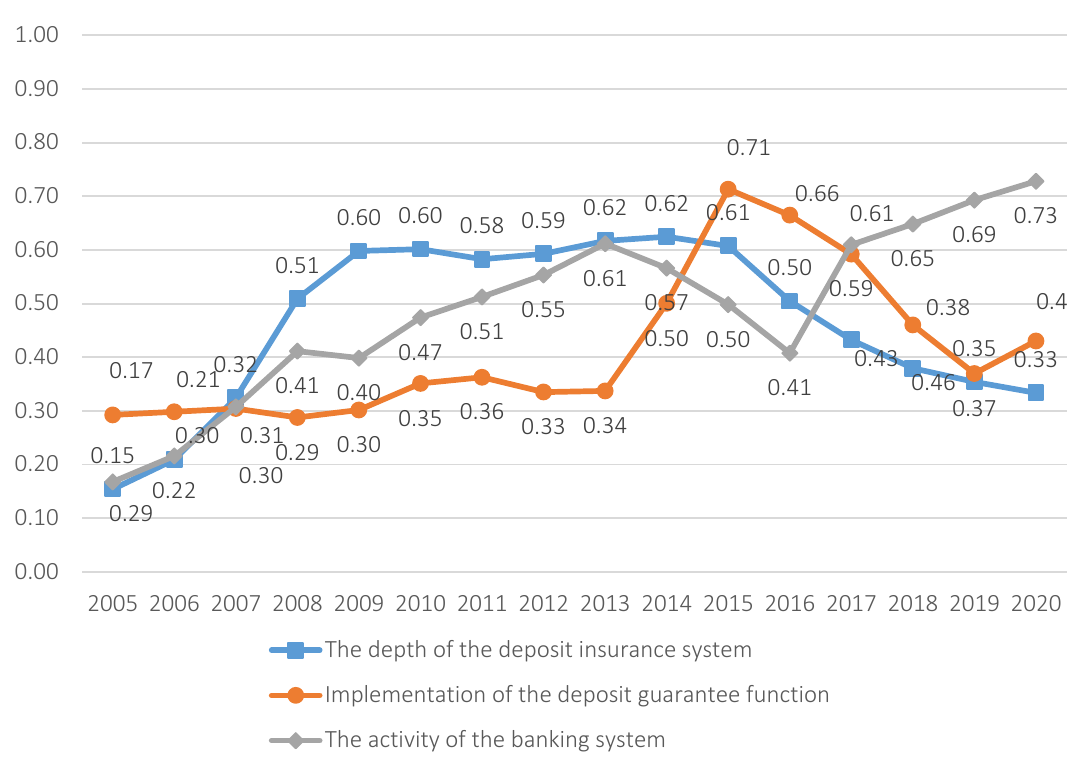
Figure 2. Integral indicators of the depth of the deposit insurance system, the deposit guarantee function implementation, and the banking system activity in 2005–2020